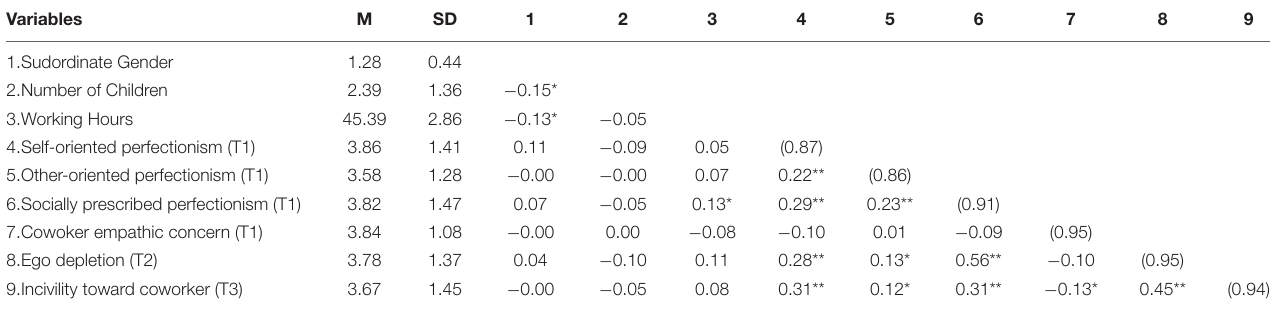
TABLE 2 | Means, standard deviations (SD) and correlations.